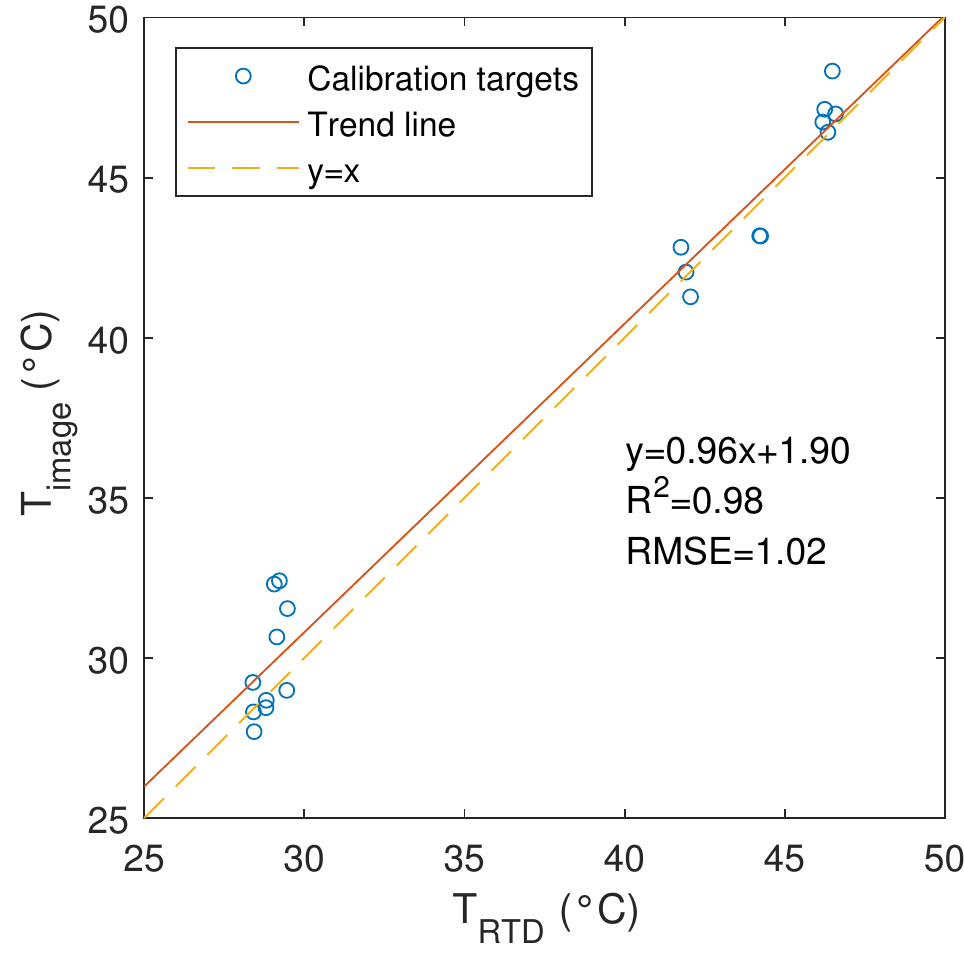
Figure 16. Correlation between image-derived temperatures (T image ) and temperatures measured by the RTD (T RTD ) for the thermal calibration targets.